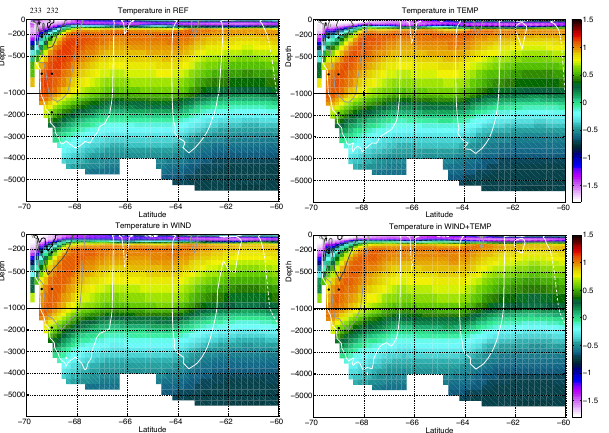
Fig. 8. Section at 0 ◦ E in simulations TEMP, REF, WIND and WIND + TEMP during June. Colors represent the temperature (in ◦ C) and lines represent the zonal currents (1cms − 1 is in white, 5cms − 1 is in light grey, 10cms − 1 is in dark grey line, dash lines correspond to eastward velocity). The white area corresponds to the ocean floor. Notice that the vertical scale is not linear; a zoom is done on the first 1000m. Black dots show the moorings AWI 233 and 232 used in Figs. 9 and